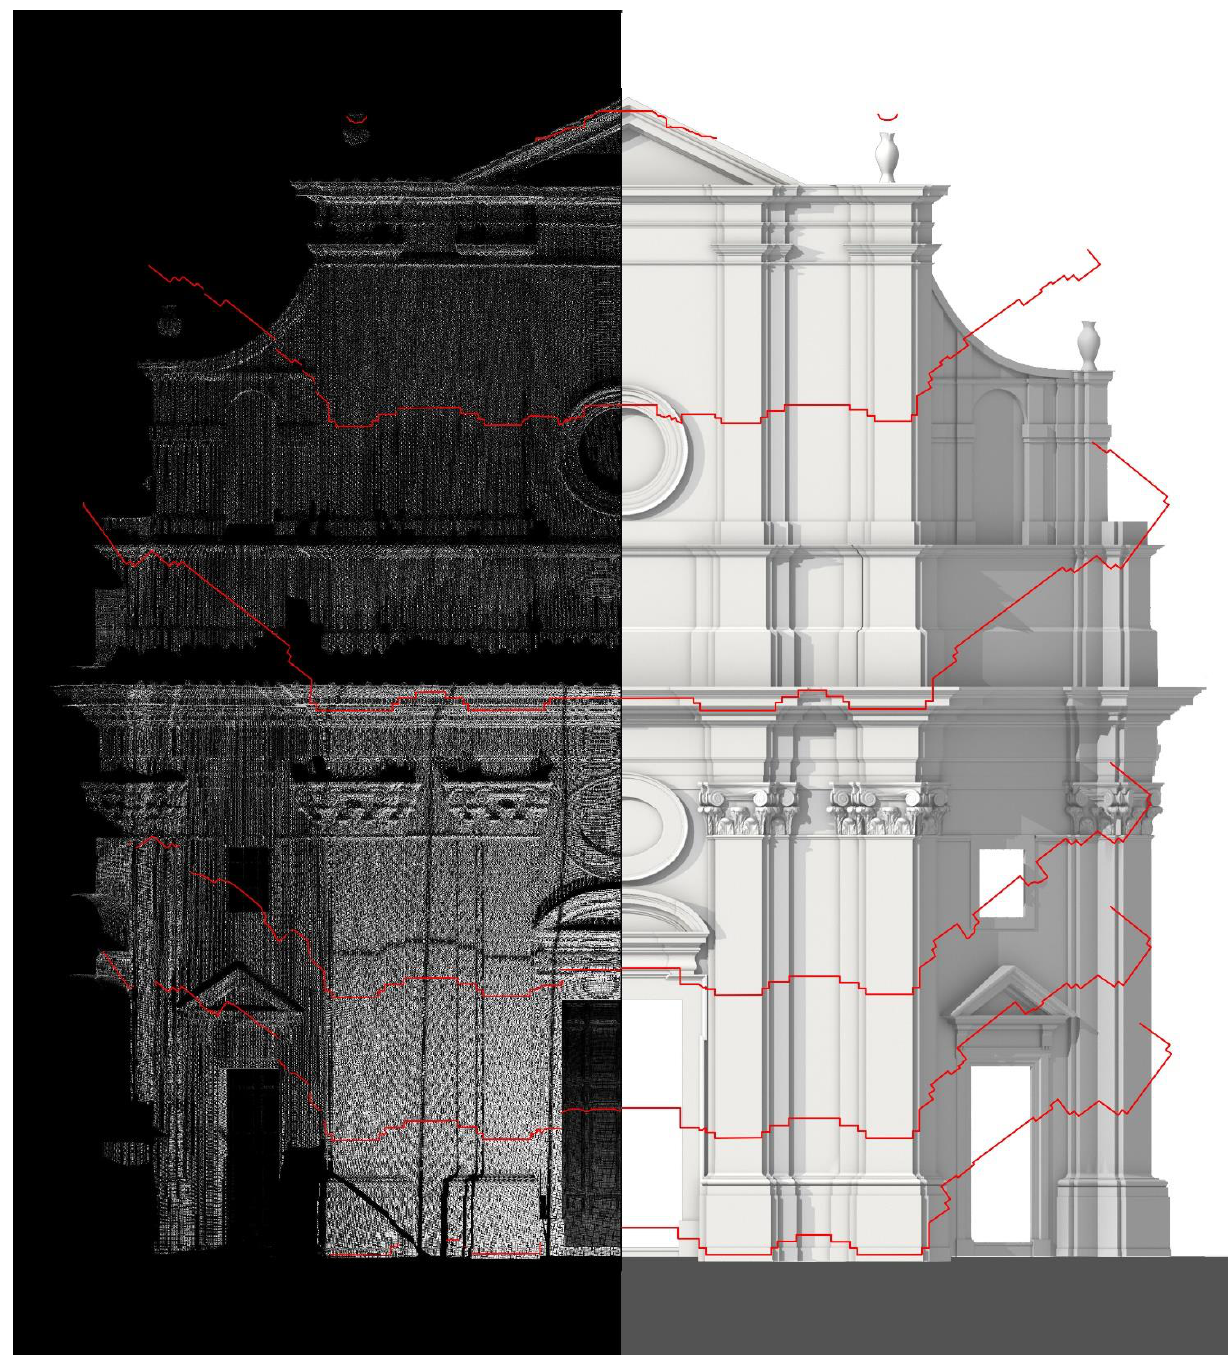
Figure 5. Visual comparison between the dense cloud (on the left) and the mathematical model (on the right) with the horizontal sections of the façade of the church of Maria SS. Assunta in Cielo survey was considered insufficient to describe the complexity